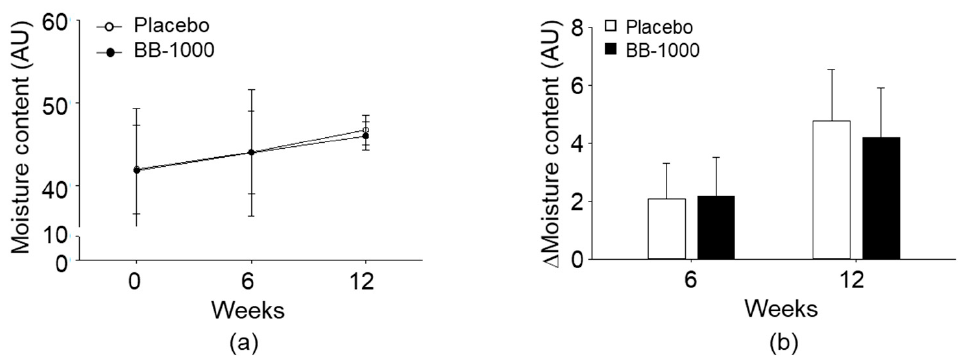
Figure 3. Effects of BB-1000 on skin moisture content: ( a ) Skin moisture content around the eyes at weeks 0, 6, and 12 of placebo and BB-1000 groups. ( b ) Changes in skin moisture content around the eyes from baseline after 6 and 12 weeks. Data are mean ± SD.